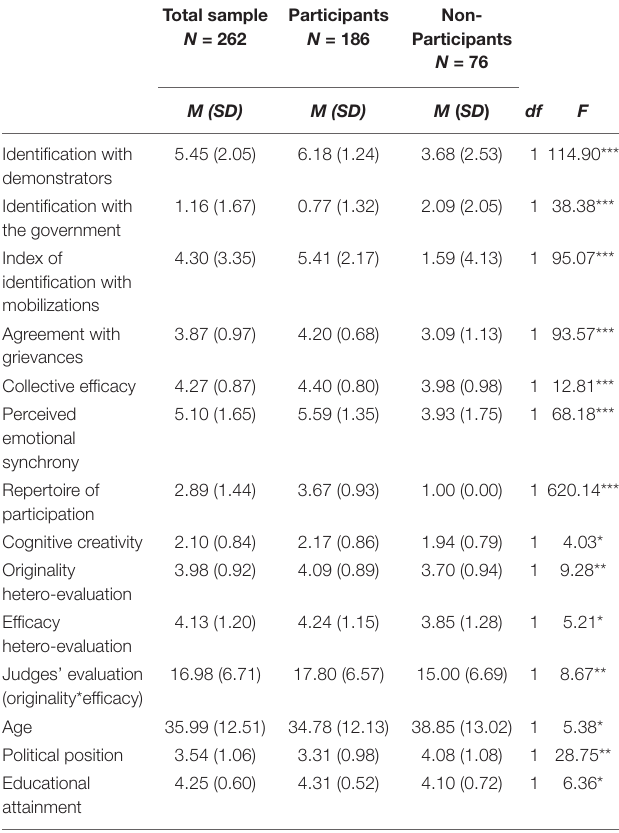
TABLE 1 | Mean scores and standard deviations on the various outcomes for the total sample and as a function of individuals’ participation vs. non-participation in the Chilean protests.